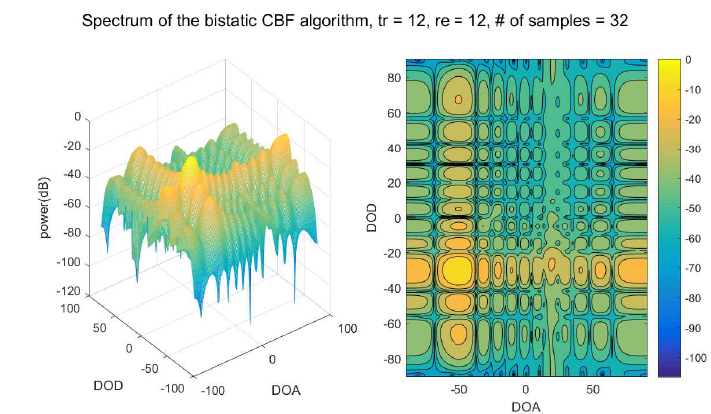
Figure 10. Spectrum of the bistatic conventional beamforming algorithm, the number of targets = 4 (case